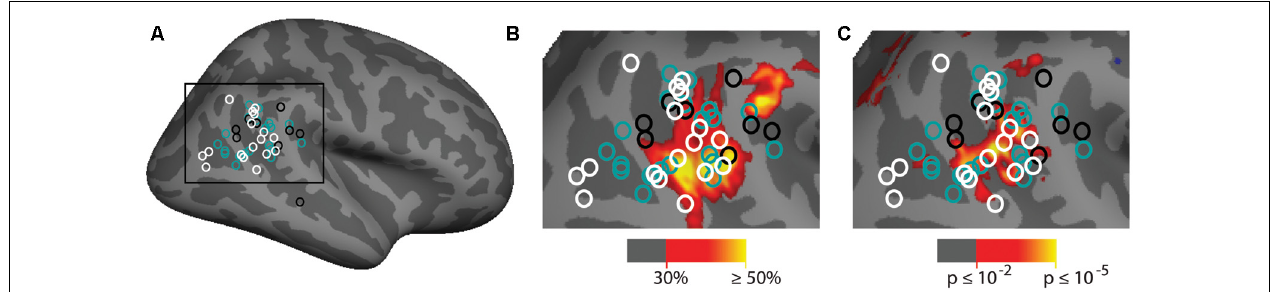
FIGURE 7 | Meta-analysis of prior attention studies identifying TPJ compared with current group average task activation. (A) Meta-analysis of 45 prior studies using either spatial cueing (white), oddball tasks (black), or another attentional method (teal) to localize the right TPJ. (B,C) Zoom-in of meta-analysis overlaid on (B) probabilistic labels built from individual subject responses to the vivid, novel oddball contrast (see Supplementary Figure S5 and Supporting Information for further details) and (C) spatial cueing group-average activation maps. See Table 1 for a list of studies